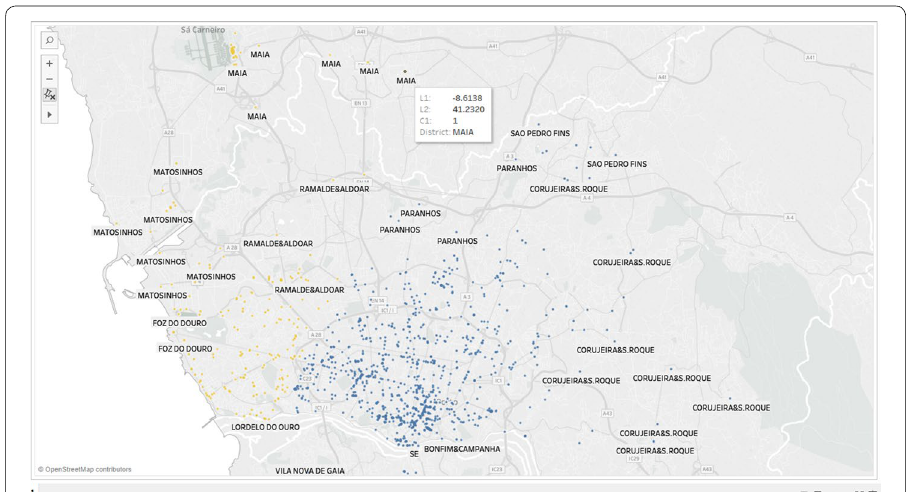
Fig. 12 Trips destination clusters on Monday at 6:00 A.M.